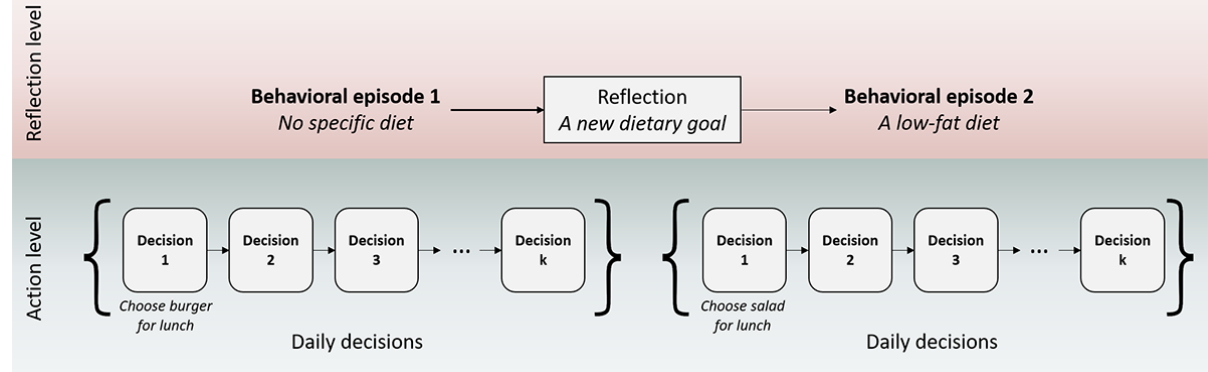
Figure 1. A two-level representation of lifestyle behavior